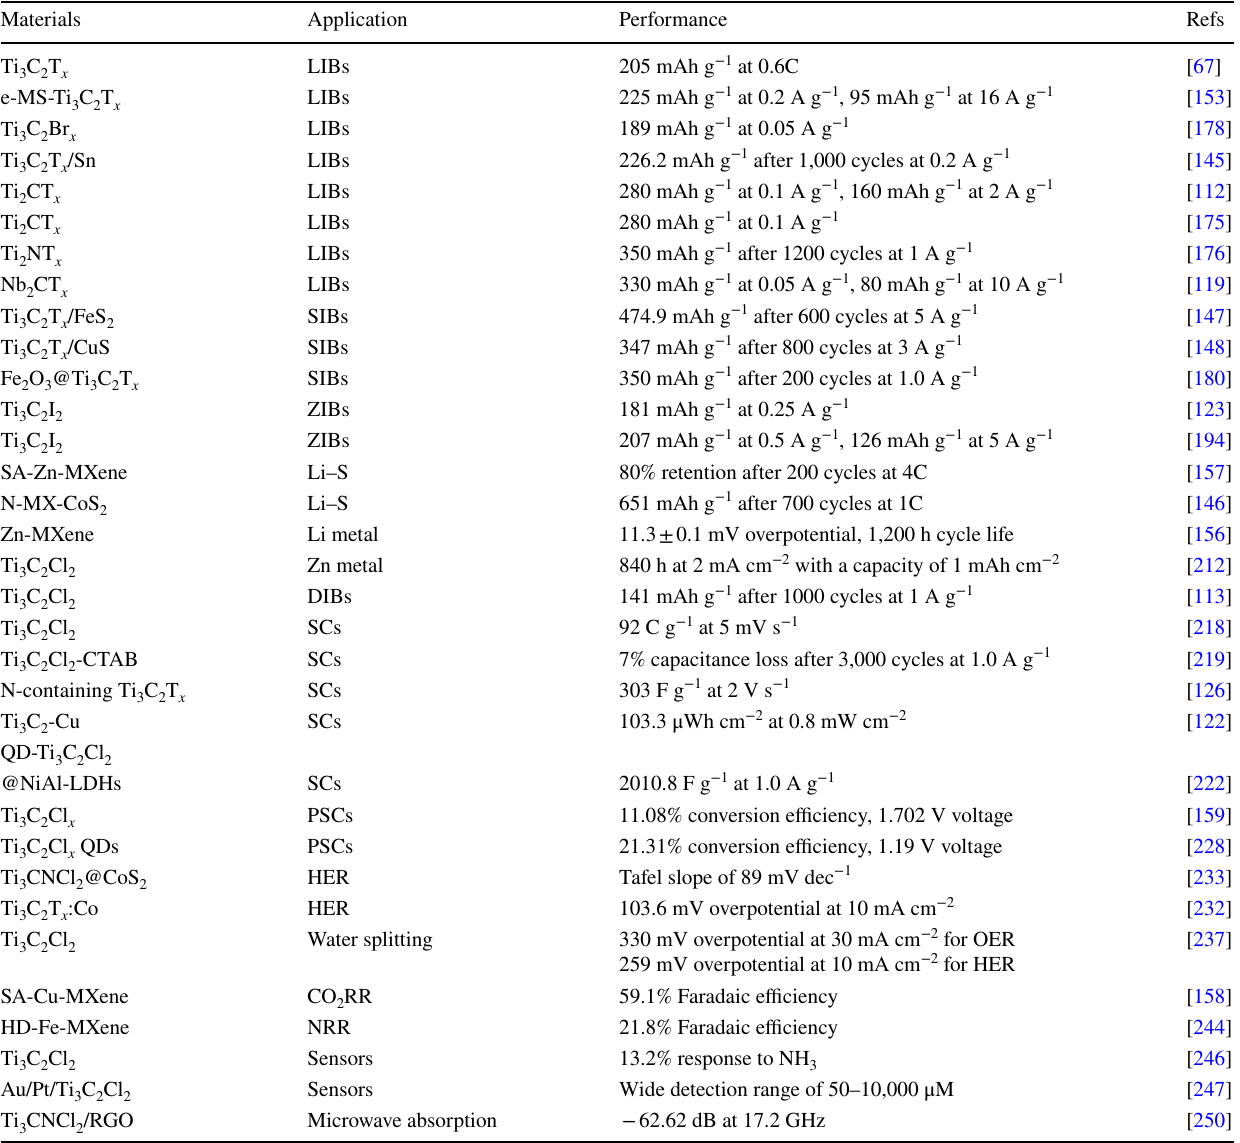
Table 3 Summary of the performance of MXenes and MXene-based materials prepared by Lewis acidic etching route